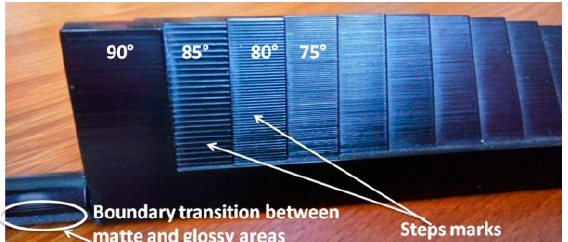
Figure 13. Flaws for samples printed in glossy style involve steps marks and a boundary transition between matte and glossy areas.